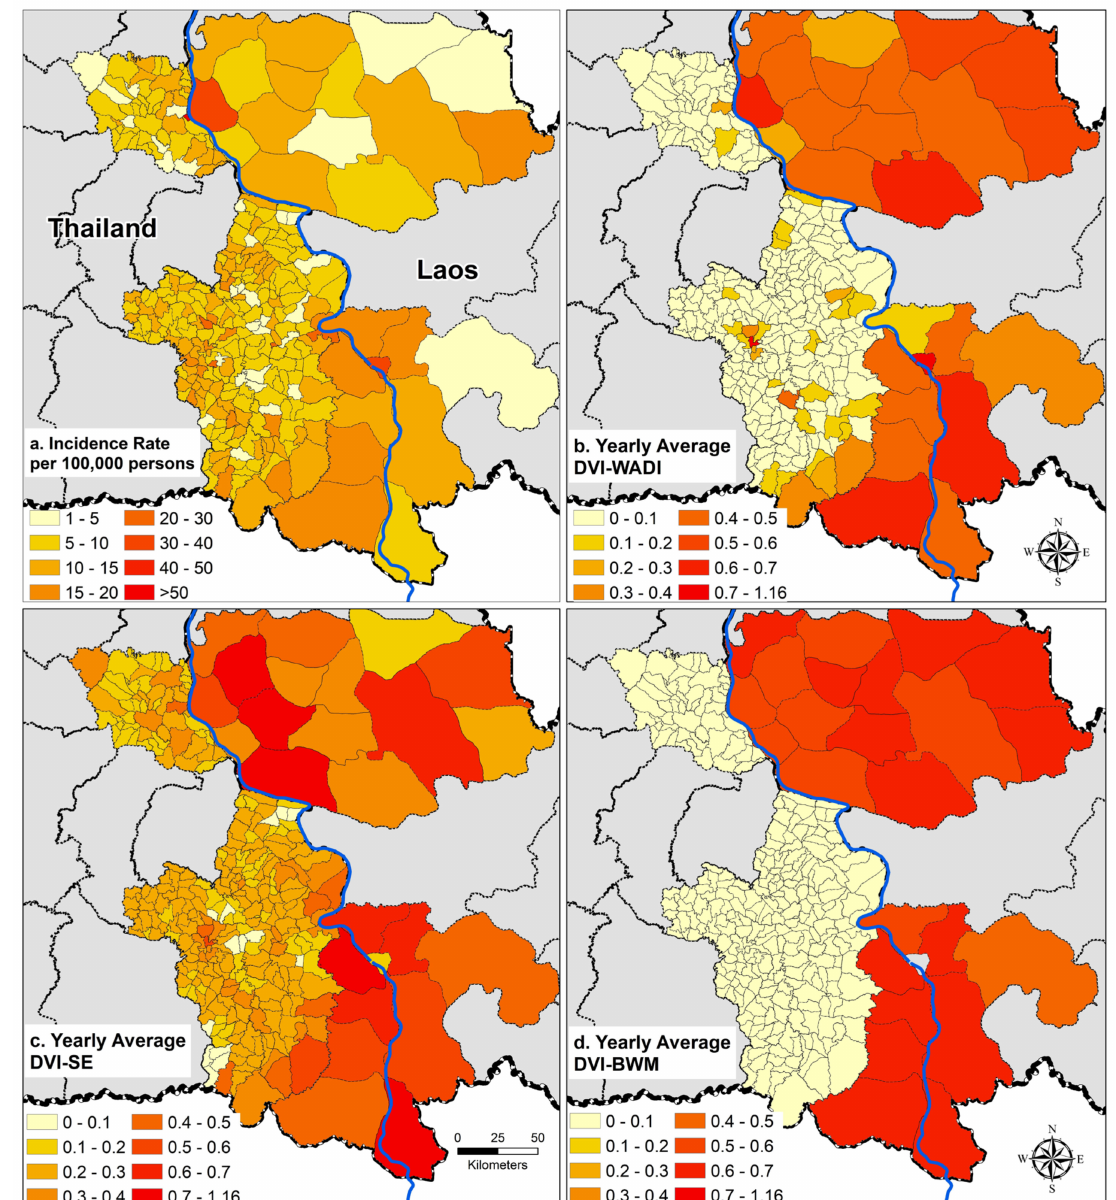
Figure 5. ( a ) Average dengue incidence rate per 100,000 persons and ( b ) Average Dengue Vulnerability Index–Water Associ- ated Disease Index (DVI WADI ) and ( c ) Average Dengue Vulnerability Index–Shannon’s Entropy (DVI SE ), and ( d ) Average Dengue Vulnerability Index–Best-Worst Method (DVI BWM ), in Laos and in Thailand from